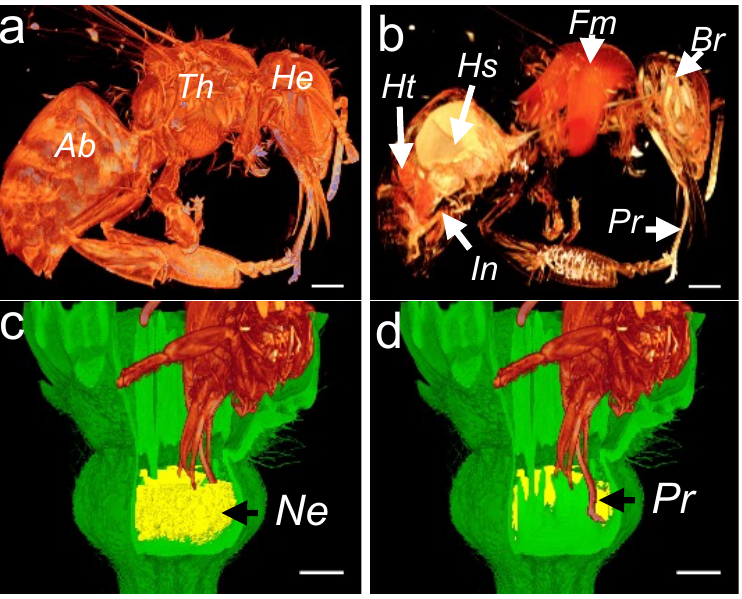
Figure 7. Reconstruction of 3D images showing the head of a honeybee sucking nectar. External ( a ) and cross ‐ sectional ( b ) 3D images of a honeybee. Three ‐ dimensional image showing nectar volume ( c ) and honeybee proboscis with the sliding glossa (tongue) pumping nectar deep into the flower corolla ( d ). Ab, abdomen; Th, thorax; He, head; Ht, heart; Hs, honey stomach; Fm, flight muscles; Br, brain; In, intestine; Pr, proboscis and glossa; and Ne, nectary. The scale bar represents 1 mm.